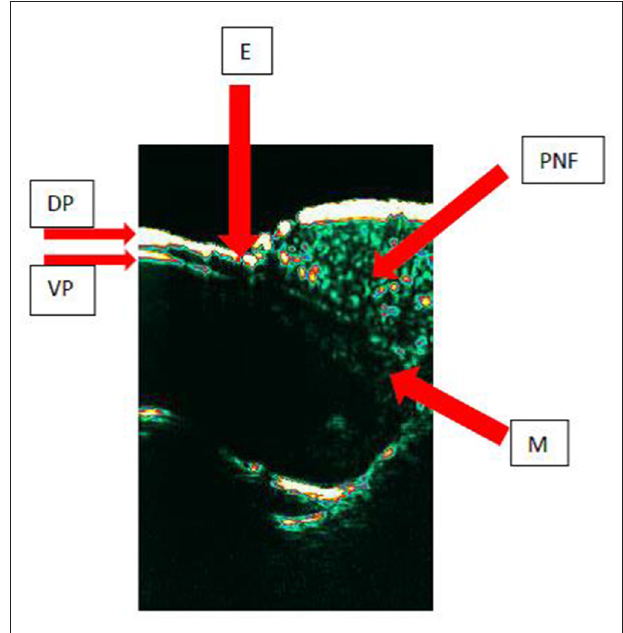
FIGURE 1 | The HF-USG image of the nail